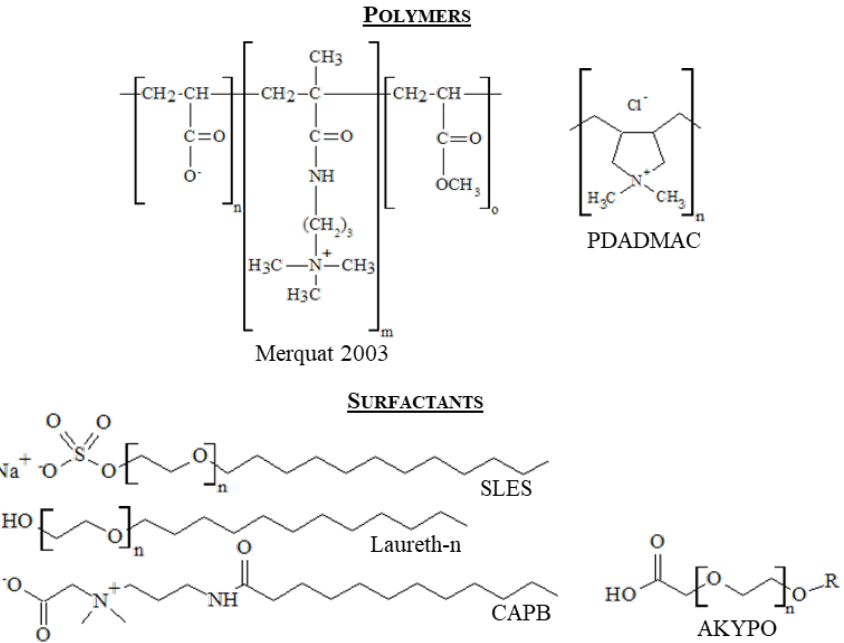
Figure 1. Molecular structures of the different polymers and surfactants used in this study. n assumes different values depending on the surfactant. n = 2 for SLES, n = 4 for AKYPO, n = 4 or 12 in Laureth-n for Laureth-4 and Laureth-12. On the other side, R corresponds to alkyl chains containing 12 carbons (dodecyl) in AKYPO.